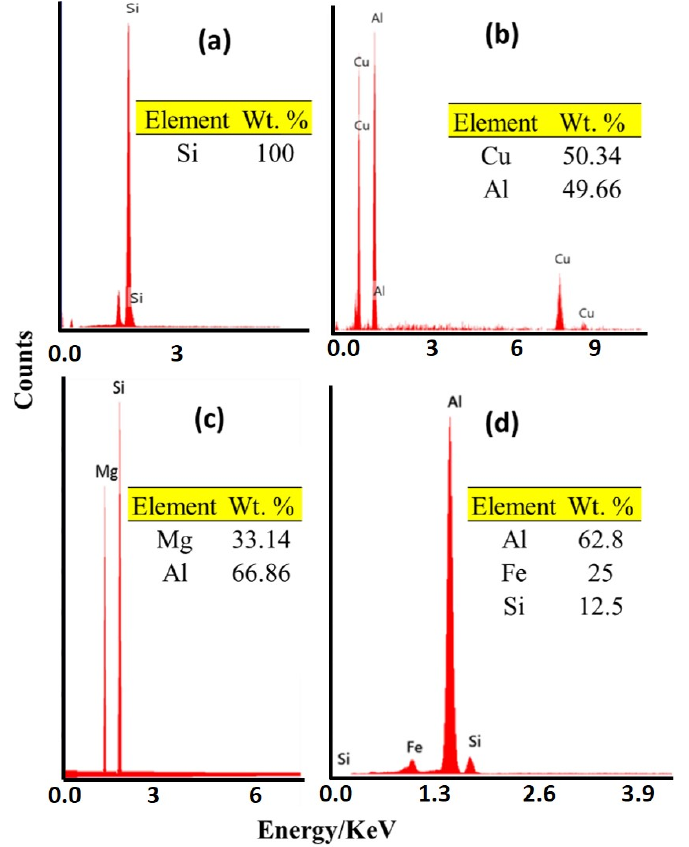
Figure 13 . ( a – d ) Illustrates the EDS spot analysis for points 1, 2, 3, and 4 indicated on the SEM micrographs in Figure 12,